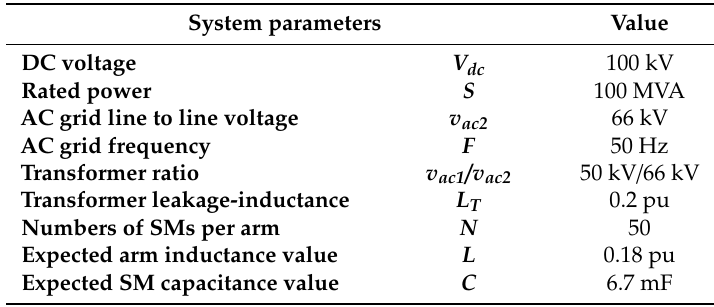
Table 2. Simulation Parameters.